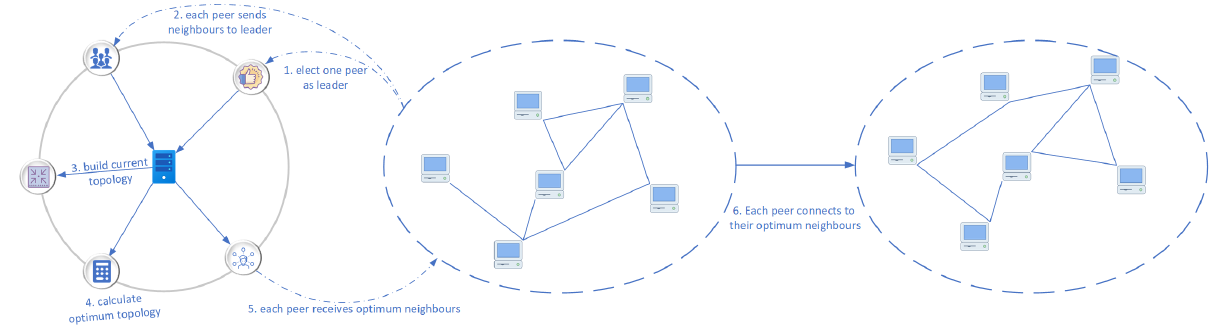
Figure 8. Semi-Distributed Topology Management Scheme used by Baniata et al. [84].